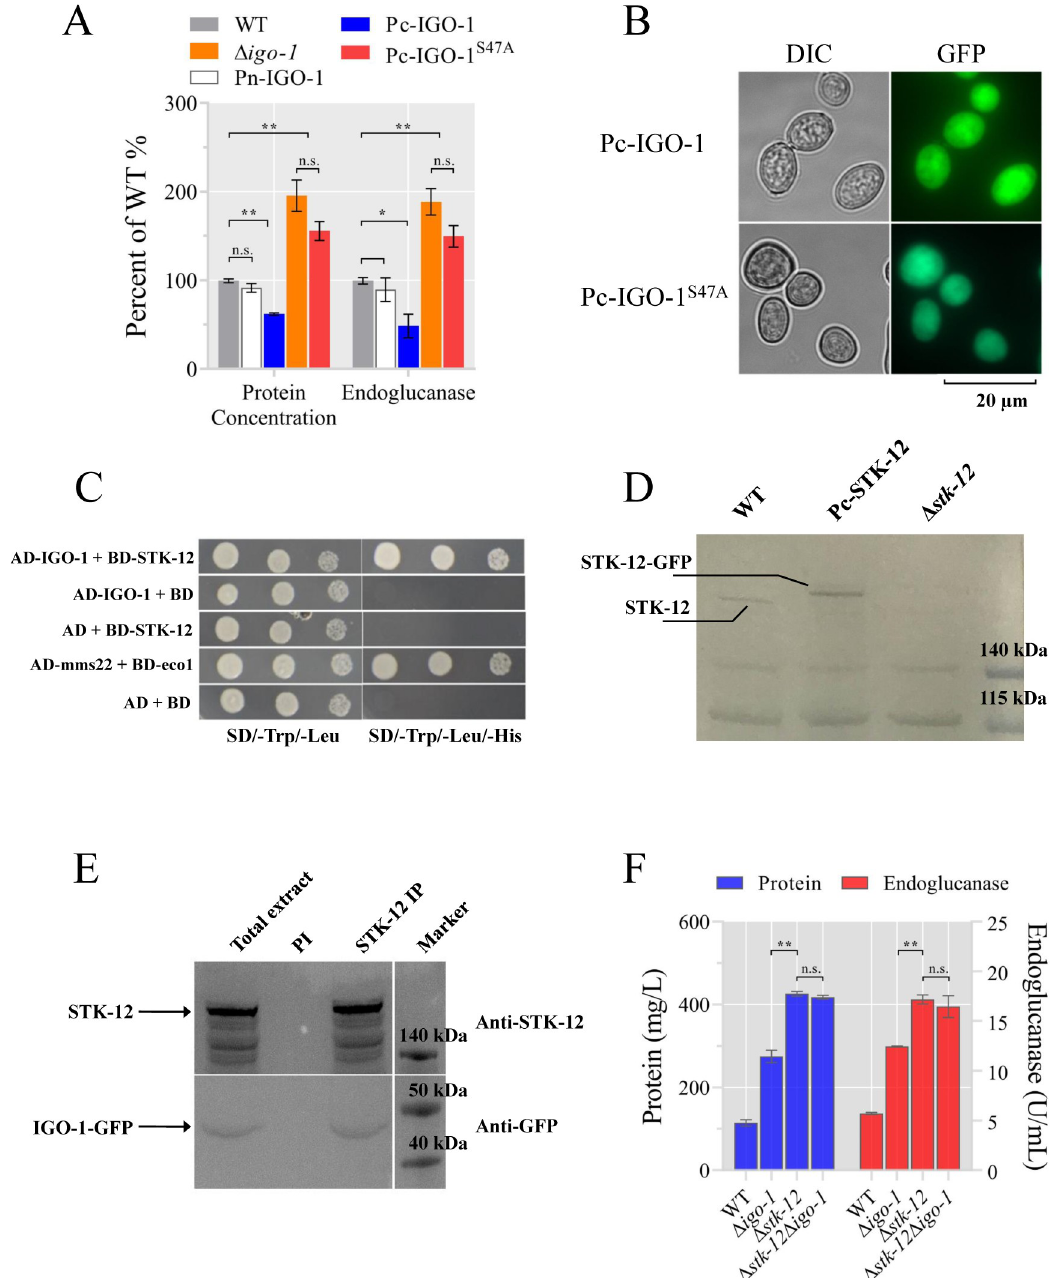
Fig 6. STK-12 interacts with IGO-1. (A) Phenotype of wild-type (WT), Δ igo-1 , Pc-NcIGO-1, and Pc-NcIGO-1 S47A strains when grown on Avicel medium. Conidia from indicated strains were separately inoculated into Avicel medium and batch cultured for 5 days. Total extracellular protein concentration and endoglucanase activity of culture broth were measured and expressed as a percentage of those in WT. Values represent means of at least three biological replicates, error bars show standard deviation. Statistical significance was determined by two-tailed Student’s t -test ( � , P < 0.05; �� , P < 0.01; n. s., not significant). (B) Subcellular localization of IGO-1 and its mutant derivative. Pc-NcIGO-1 and Pc-NcIGO-1 S47A strains were grown on MM plates for 5 days. (C) Yeast two-hybrid assay demonstrating interaction between STK-12 and NcIGO-1. Yeast cells were grown on SD/-Trp/-Leu or SD/-Trp/-Leu/-His medium for 3 days. (D) Western blot analyses showing that polyclonal antibody specifically recognizes STK-12 protein in WT and Pc-STK-12 strains but not in Δ stk-12 mutant. Arrows indicate STK-12 or STK-12-GFP protein band detected by STK-12 polyclonal antibody. (E) Immunoprecipitation assays using STK-12 antiserum showing that STK-12 interacts with IGO- 1 in vivo . PI, preimmune serum. (F) stk-12 and igo-1 probably act in same pathway to regulate cellulases. Conidia from WT and stk- 12 and igo-1 single ( Δ stk-12 , Δ igo-1 ) and double ( Δ stk-12 Δ igo-1 ) mutants were inoculated into Avicel medium and